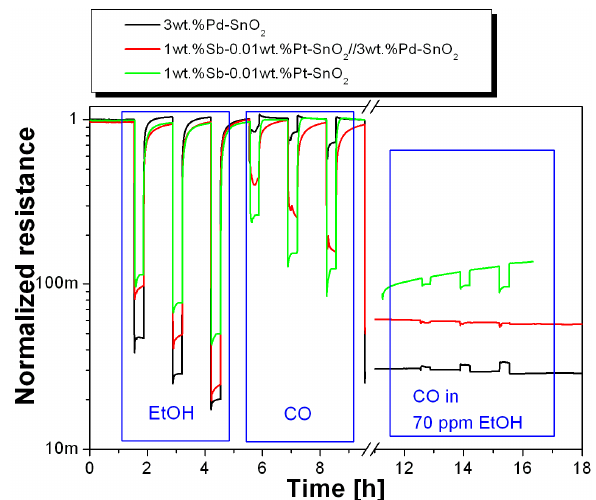
Figure 4. Sensing results at 300 °C in dry air for the system 1 wt % Sb–0.01 wt % Pt-SnO 2 //3 wt % Pd-SnO 2 .